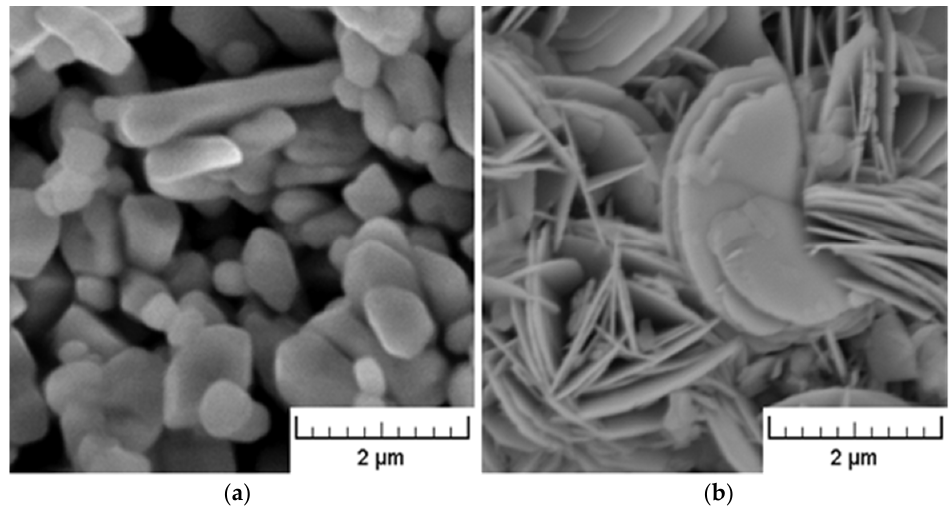
Figure 1. SEM pictures of BaSO 4 powder ( a ) and BiOCl powder ( b ).